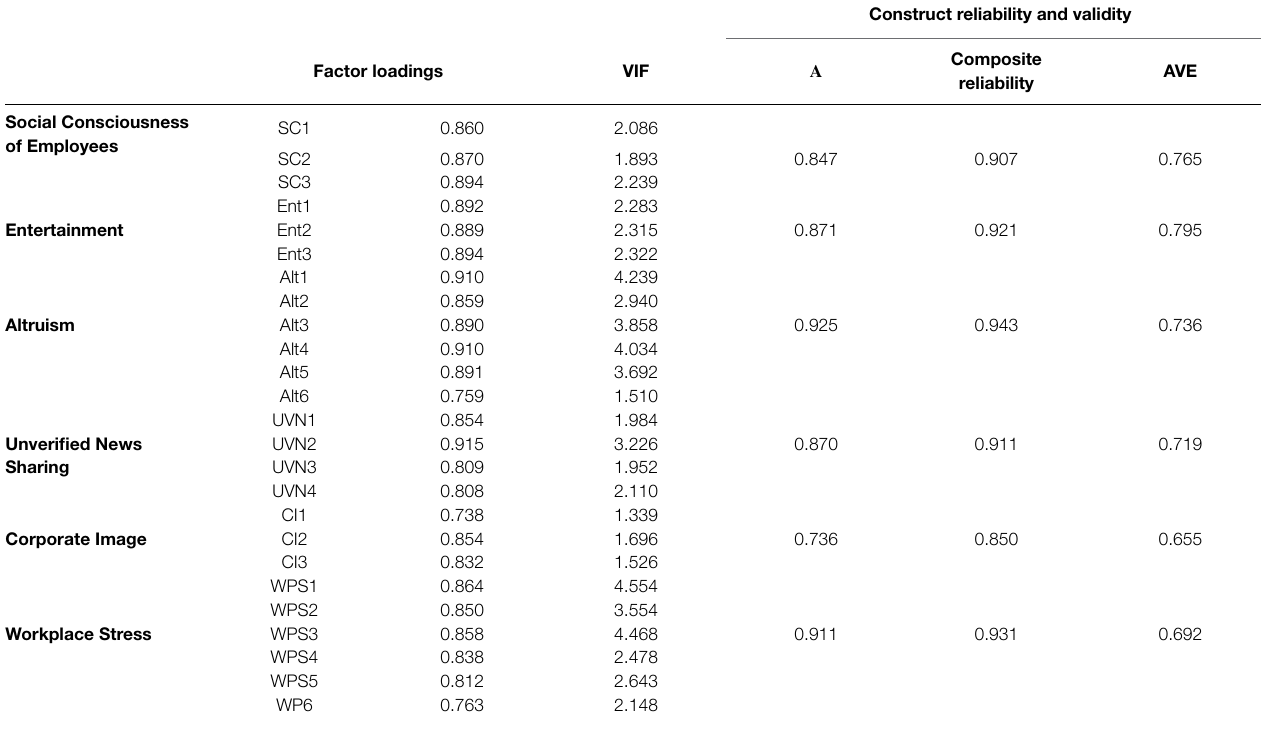
TABLE 6 | Model assessment (moderation).